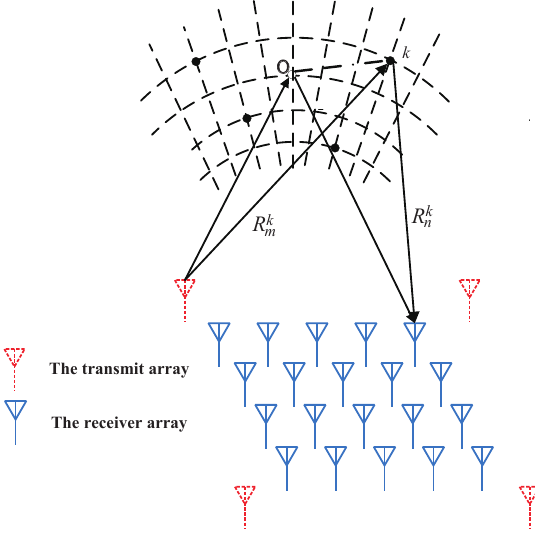
Figure 1. The MIMO radar 3D imaging